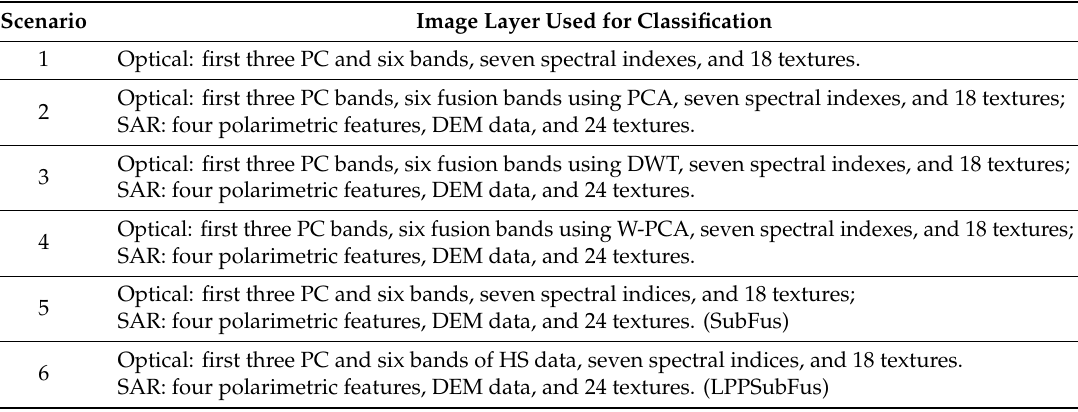
Table 3. Classification scenarios using the support vector machine and neural network algorithms.